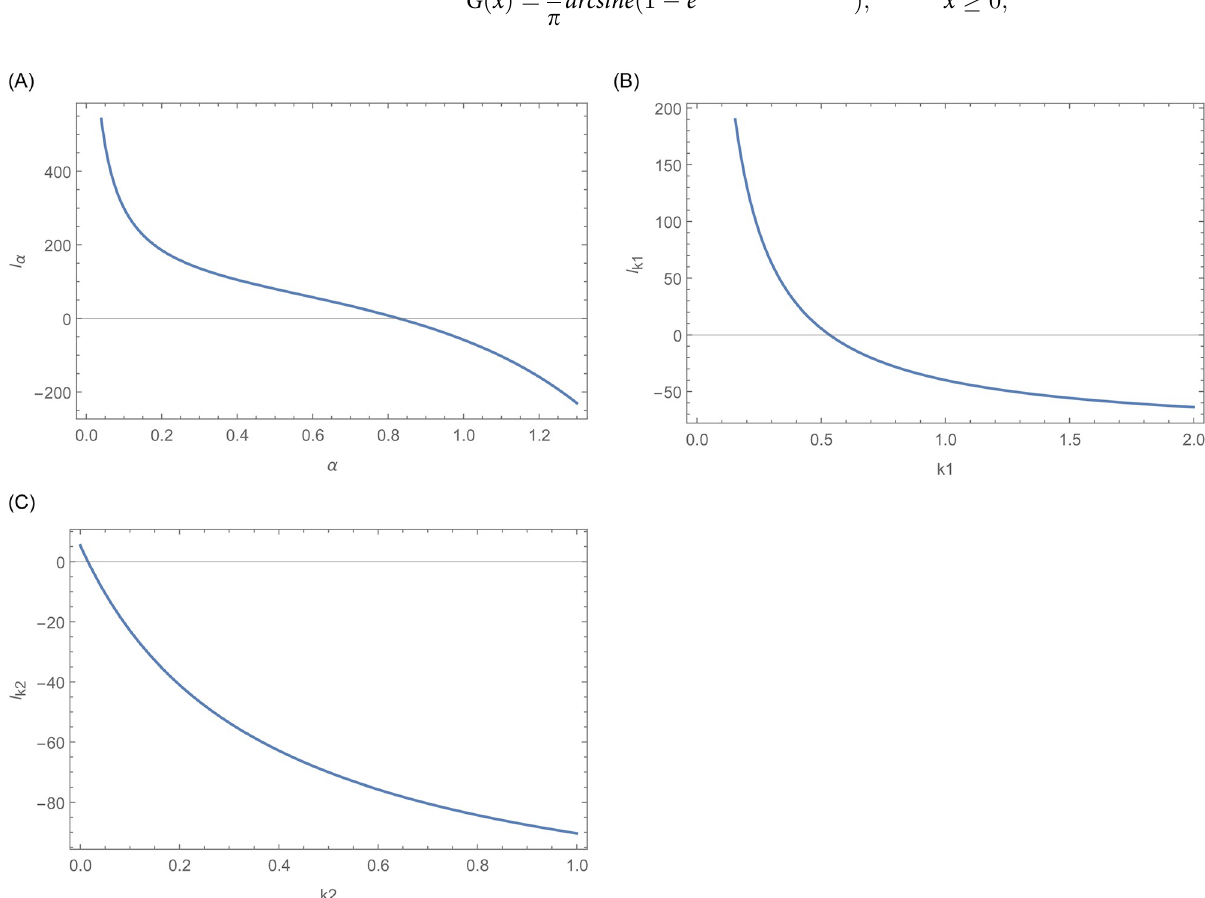
Fig 15. This figure indicates the existences of the log likelihood function as each curve intersect the x-axis at one point.